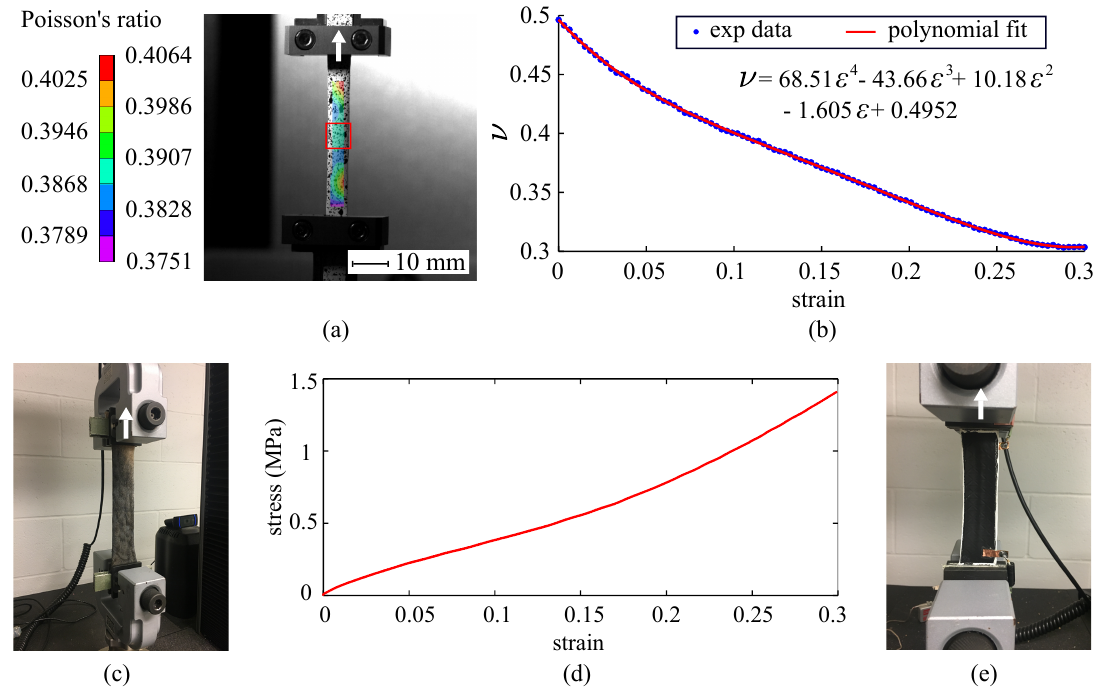
Figure 3. ( a ) Typical digital image correlation (DIC) results showing the Poisson’s ratio distribution under 20% strain, with the region of interest shown as a red rectangle; ( b ) the corresponding transverse Poisson’s ratio curve obtained by averaging values within the region of interest; ( c ) picture of the animal skin subjected to uniaxial strain; ( d ) experimental uniaxial stress versus strain curve of the free-standing animal skin; and ( e ) picture of the free-standing SEC subjected to strain (the arrows illustrates the loading